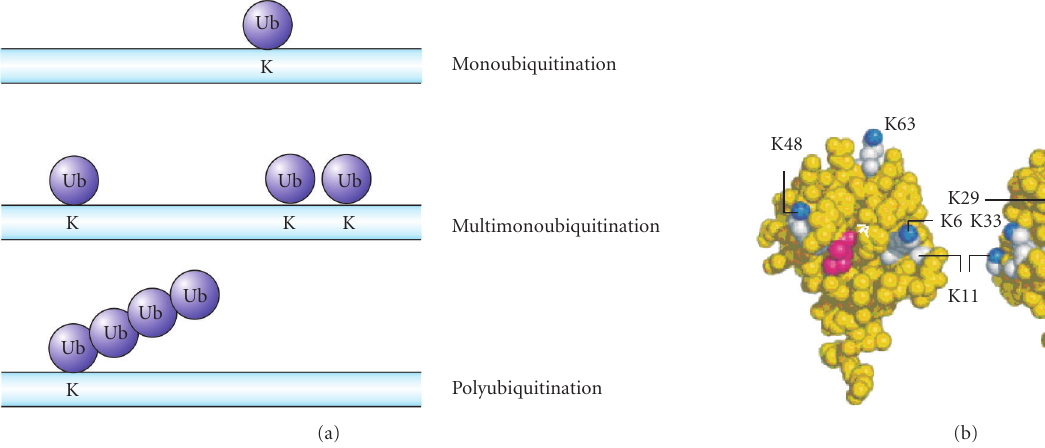
Figure 3: (a) Ubiquitin can be added as a single molecule at one or more sites. Alternatively, the branched chains of polyubiquitin may be formed. (b) Space-filled model of ubiquitin indicating the seven lysine residues (see